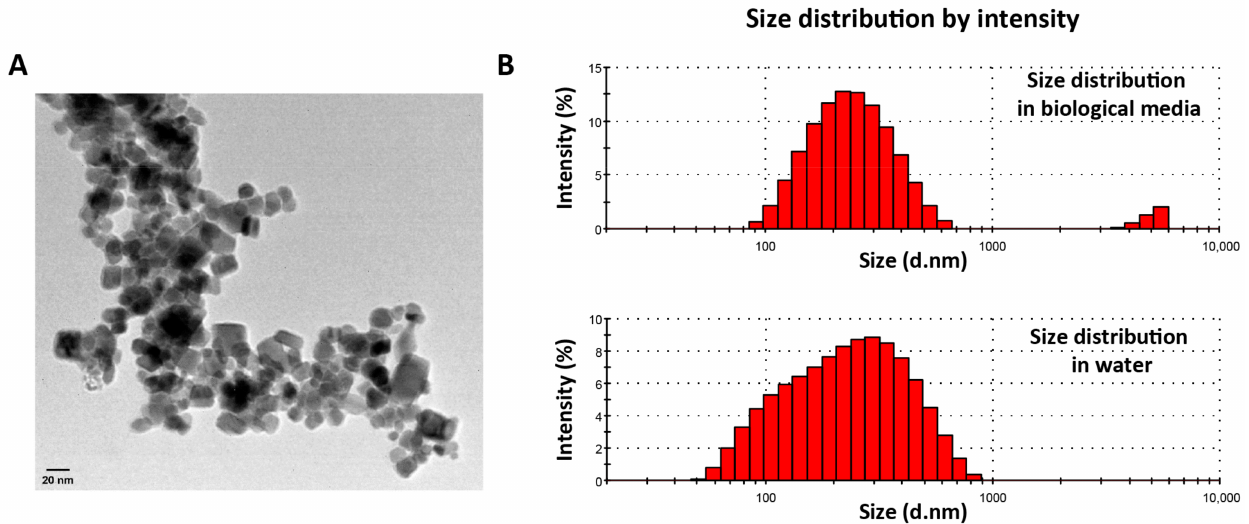
Figure 1. TEM micrographs of MAG.PEG . ( A ) A representative micrograph of the MAG.PEG dispersion is shown. The morphology and size of nanoparticles is appreciated with this technique. Scale bar = 20 nm. ( B ) Histograms arising from DLS